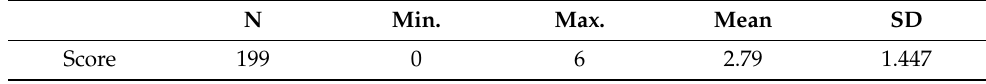
Table 3. Rate of correct answers by pictogram (%).